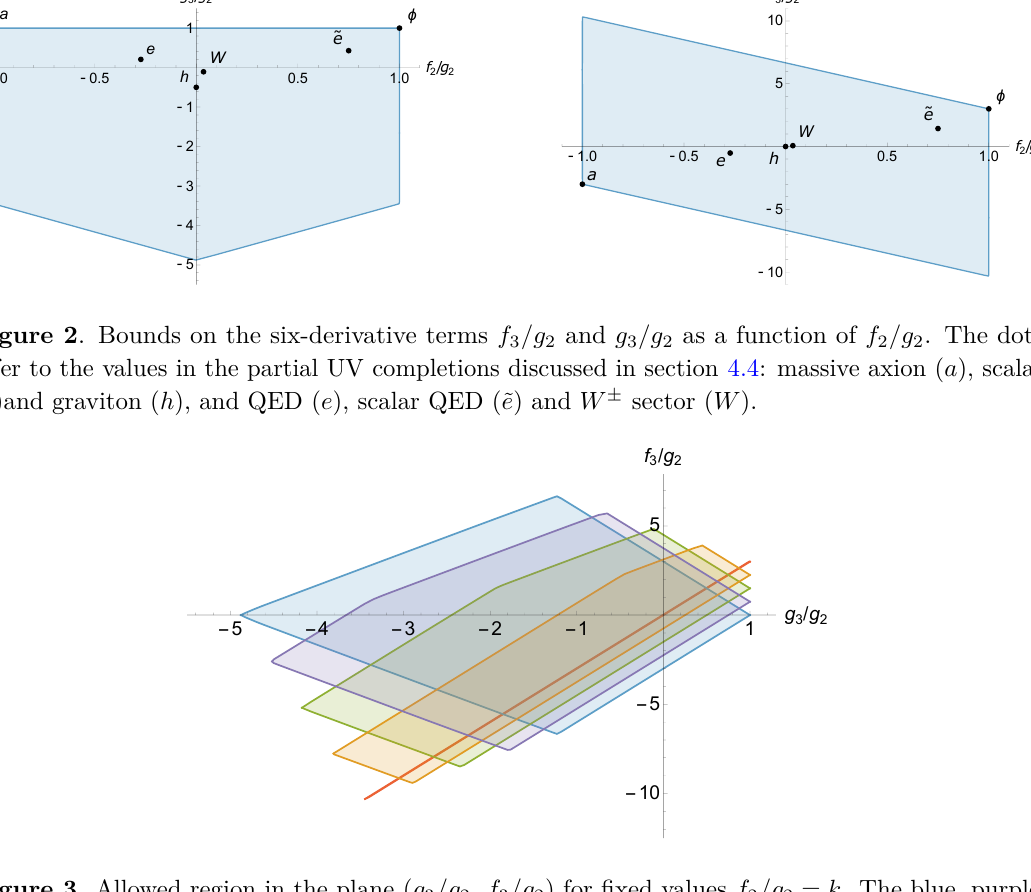
Figure 3 . Allowed region in the plane ( g 3 /g 2 , f 3 /g 2 ) for fixed values f 2 /g 2 = k . The blue, purple, green, yellow and red regions correspond respectively to k = 0 , 0 . 25 , 0 . 5 , 0 . 75 , 1